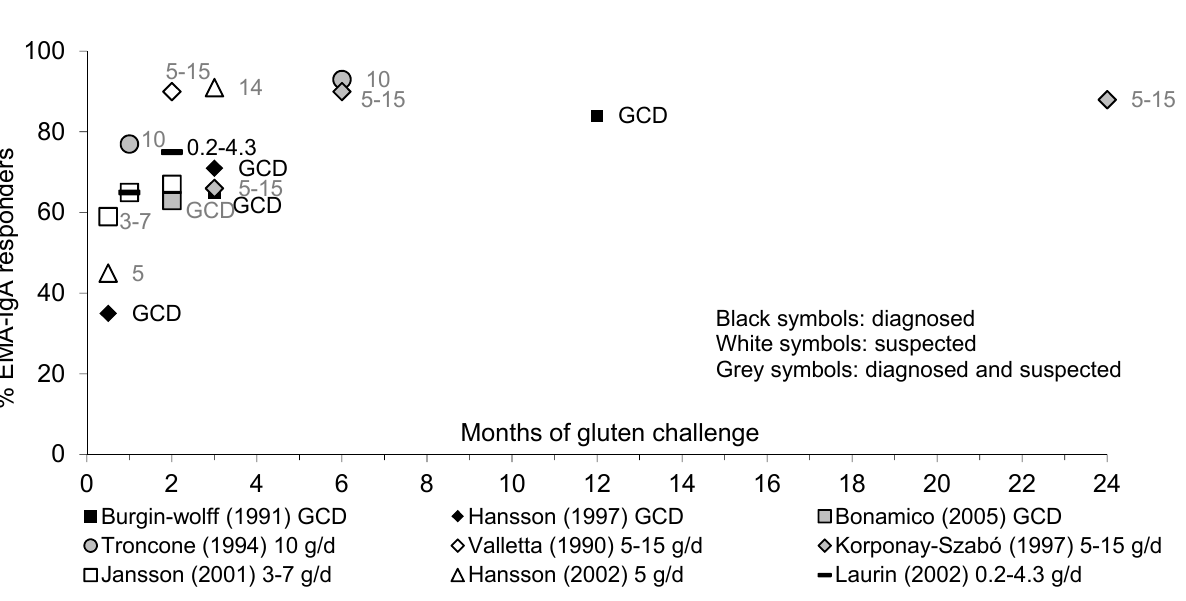
Figure 3. Percentage of pediatric patients with diagnosed or suspected CD showing an anti-endomysial antibodies (EMA)-IgA response to gluten over